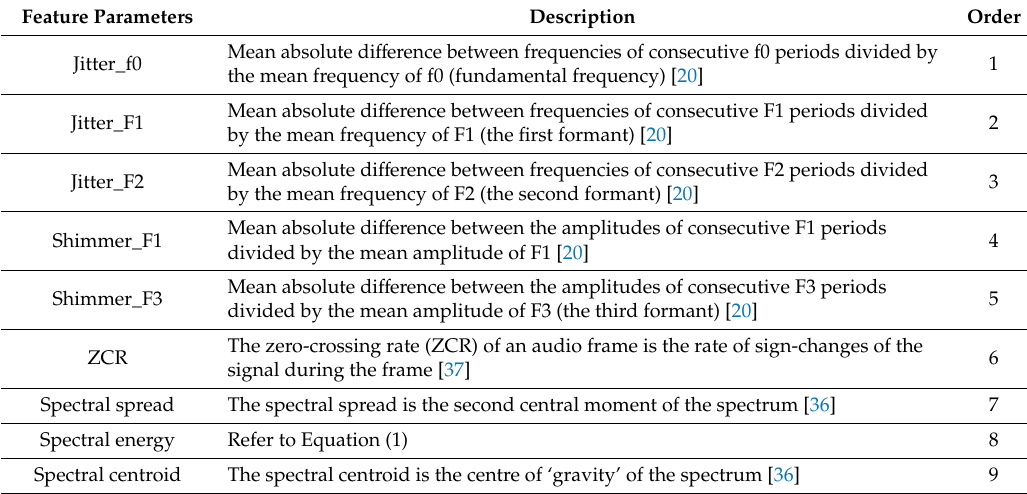
Table 2. Description of feature